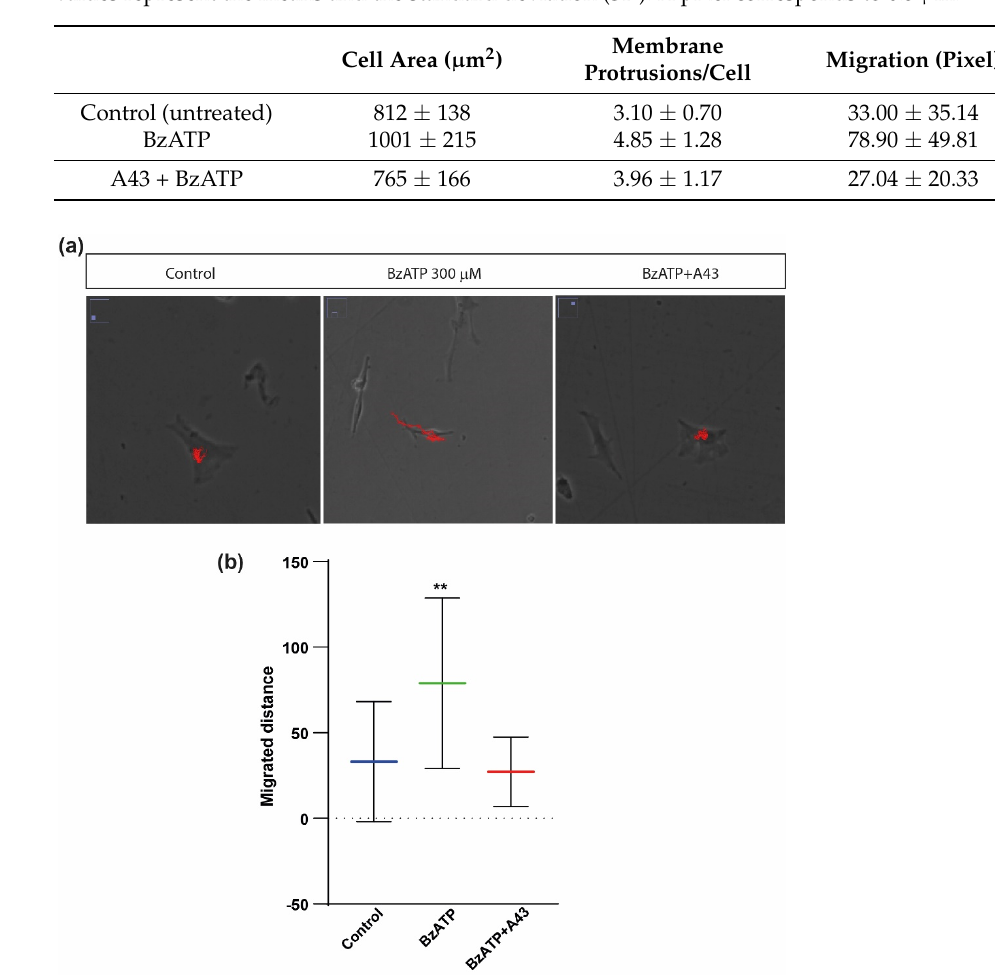
Table 1. Statistics on data depicted in Figures 2 and 3 obtained after 3 h of time-lapse video micros- copy. Values represent the means and the standard deviation (SD). A pixel corresponds to 0.5 µm.